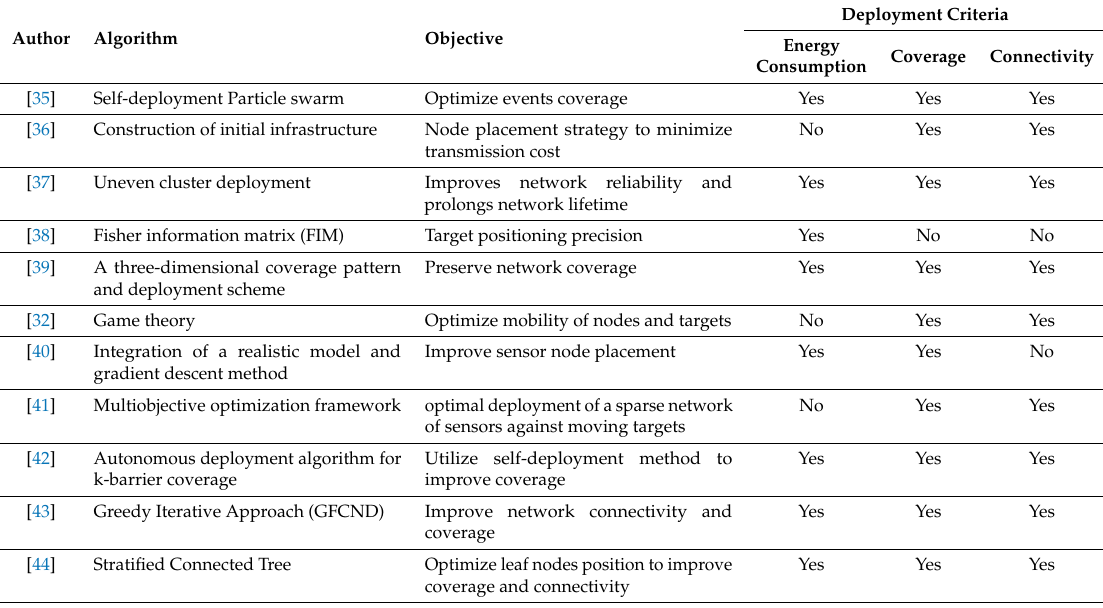
Table 3. Mobile Deployment Algorithm in